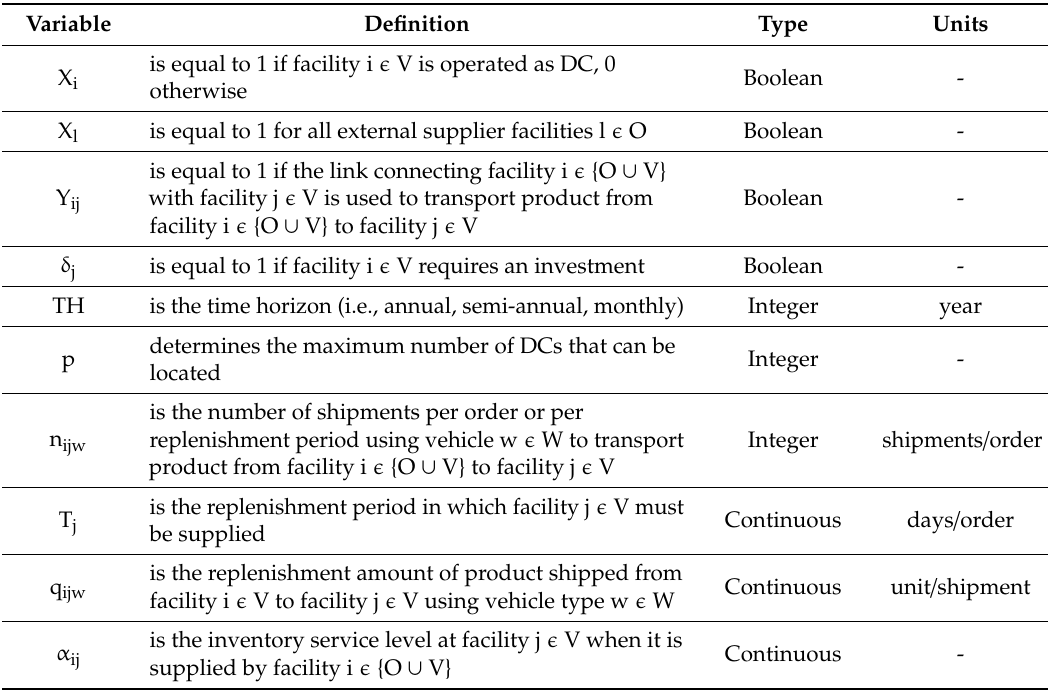
Table 2. CLITraP-HTF decision